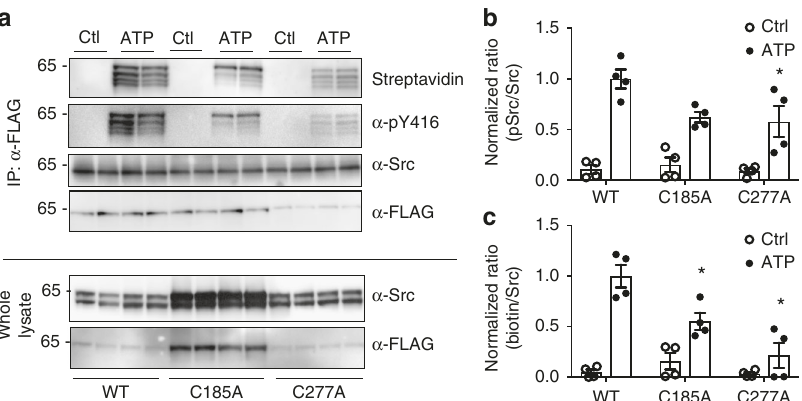
Fig. 3 ATP induces Src sulfenylation at Cys-185 and Cys-277 that promote pTyr-416 phosphorylation in H292 cells. a H292 cells were transiently transfected with c-terminal FLAG-tagged WT, C185A, and C277A Src (Src-FLAG), and preloaded with DYn-2 and stimulated with 100 µ M ATP for 10 min. Derivatized cell lysates or α -FLAG-puri fi ed were analyzed by western blot with indicated antibodies. a Representative western blots of two separate experiments. b Normalized ratios of phosphorylation-to-total Src. c Normalized ratios of biotinylation-to-total Src. Data represent mean ± s.e.m from